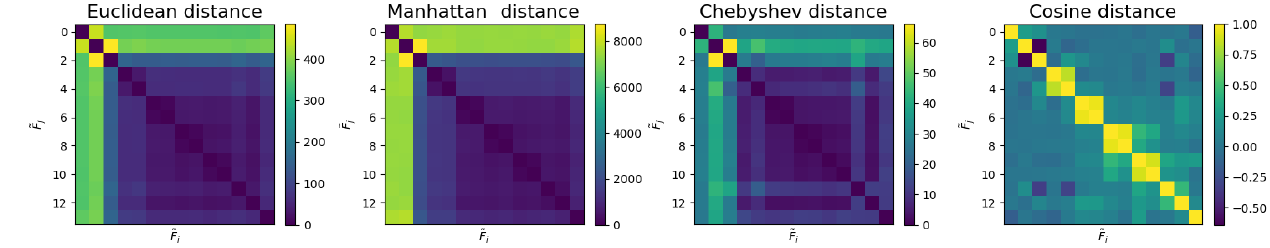
Figure 7. Distance matrices between the principal components.